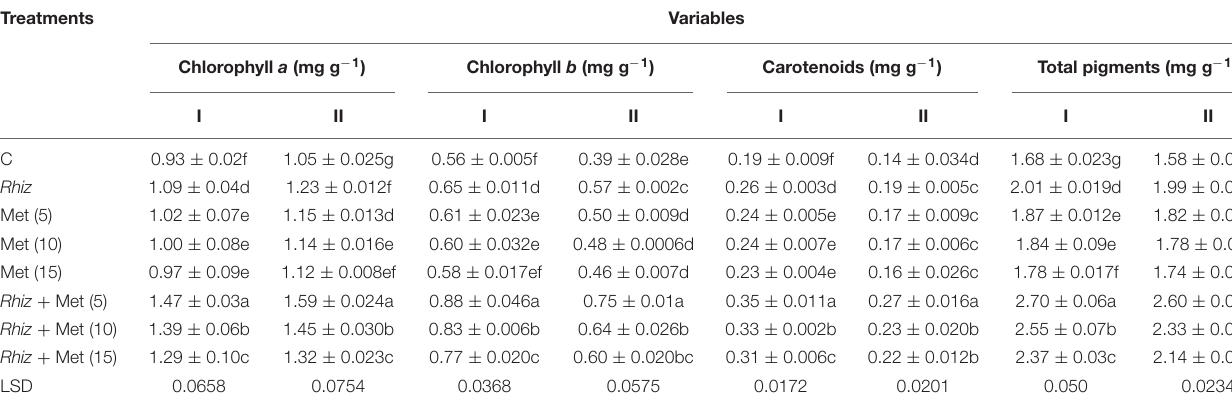
TABLE 7 | Chickpea physiological traits at different L-methionine levels and seed inoculation with Rhizobium .